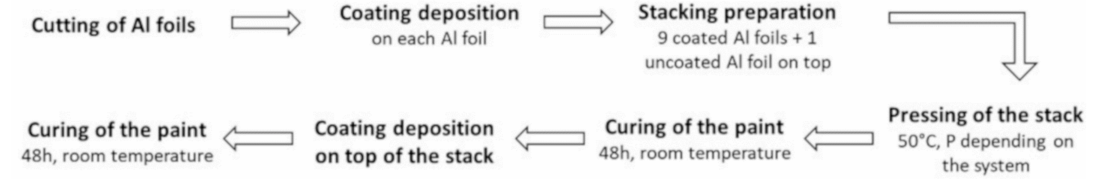
Figure 2. IPML elaboration process.